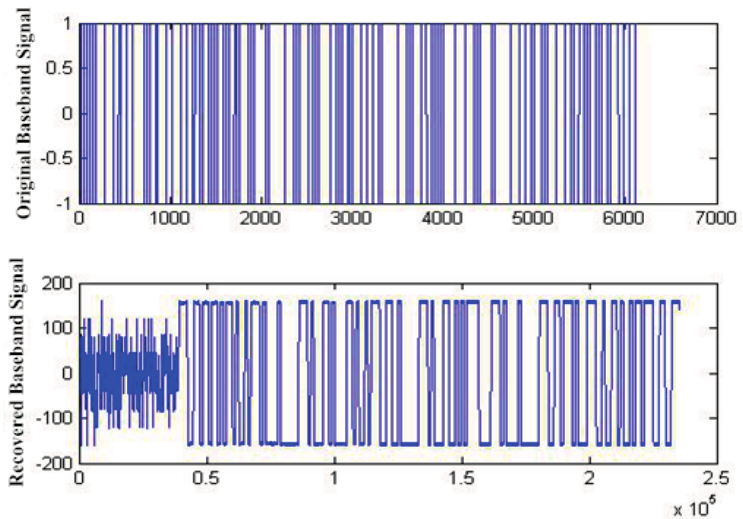
Figure 23. Simulation of code